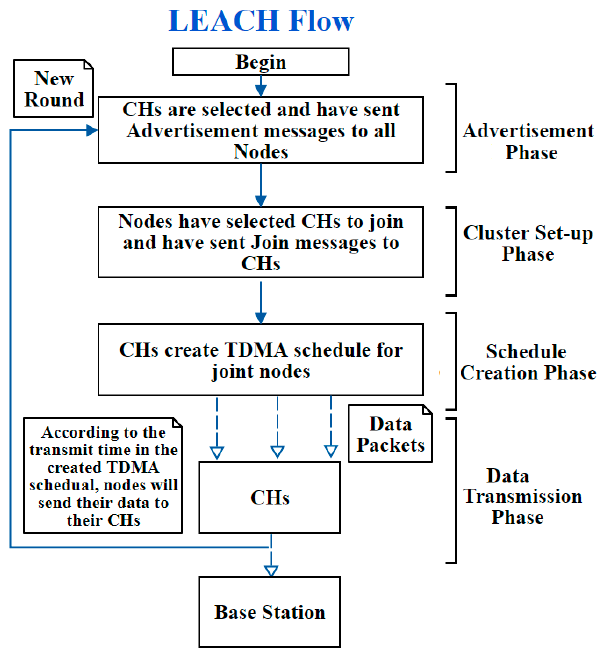
Figure 3. LEACH routing protocol flow.